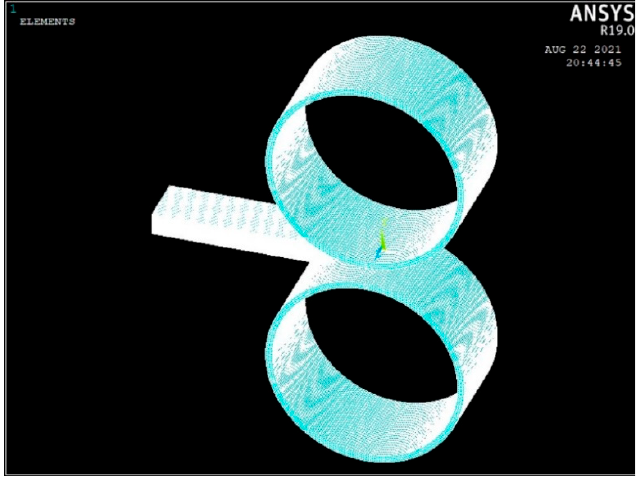
Figure 4. Geometry model of a Ti/Steel bimetal clad plate.